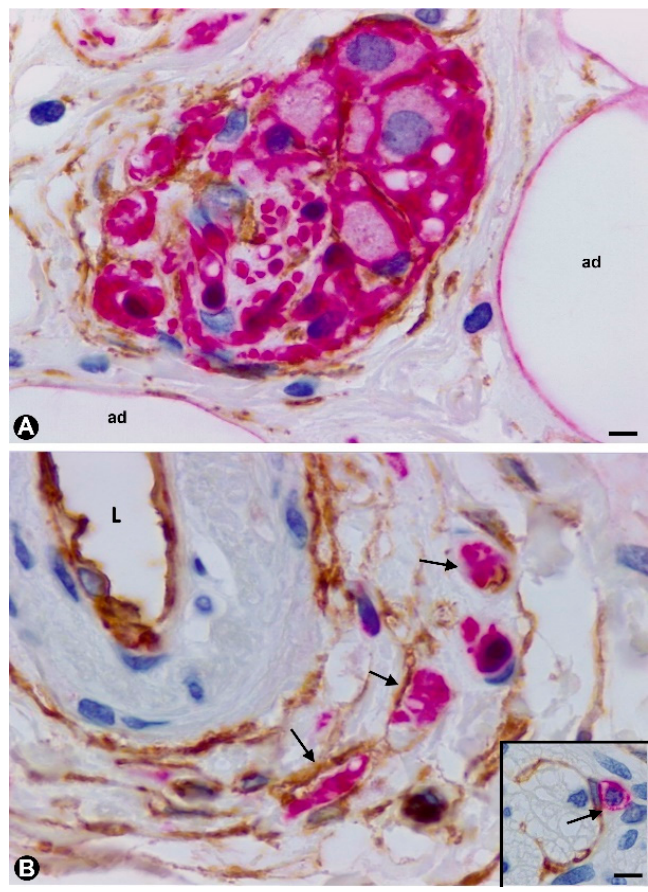
Figure 4. TCs/CD34+SCs around nerve fibres (Schwann cells and axons) and neuronal–glial units growing in the appendiceal adipose and connective tissues, and in the adventitia of blood vessels in the presence of mast cells. Sections double-immunostained with anti-CD34 (brown) and anti-S100 (red) ( A ), anti-CD34 (brown) and anti-neurofilaments (red) ( B ) and anti-CD34 (brown) and c-kit (red) (insert in B). A: TCs/CD34+SCs (brown) are observed around neuronal–glial units between adipocytes (ad). It should be noted that the satellite glial cells are stained in red. B: Nerve fibres between the TCs/CD34+SCs of blood vessel adventitia (L: vessel lumen). Insert of B: A c-kit immunostained mast cell (red) associated with a TC/CD34+SC) (brown). Bar: A, 20 µm; B, 40 µm; insert of B, 10 µm.